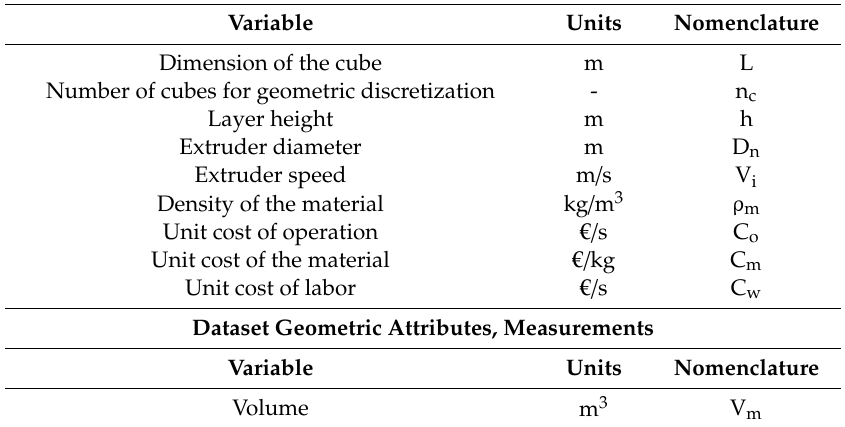
Table 12. Definition of the properties and the technological characteristics used in the definition of the family or Dataset of the BIM E 1 and E 2 construction elements.